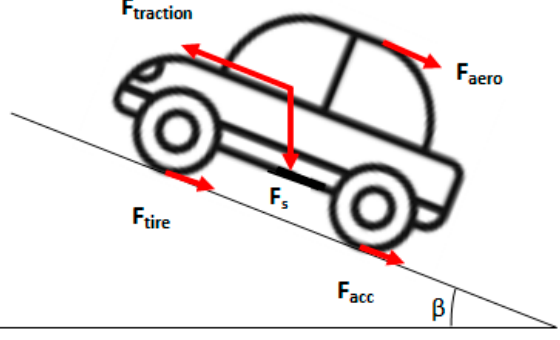
Figure 2. Forces exerted on the vehicle.